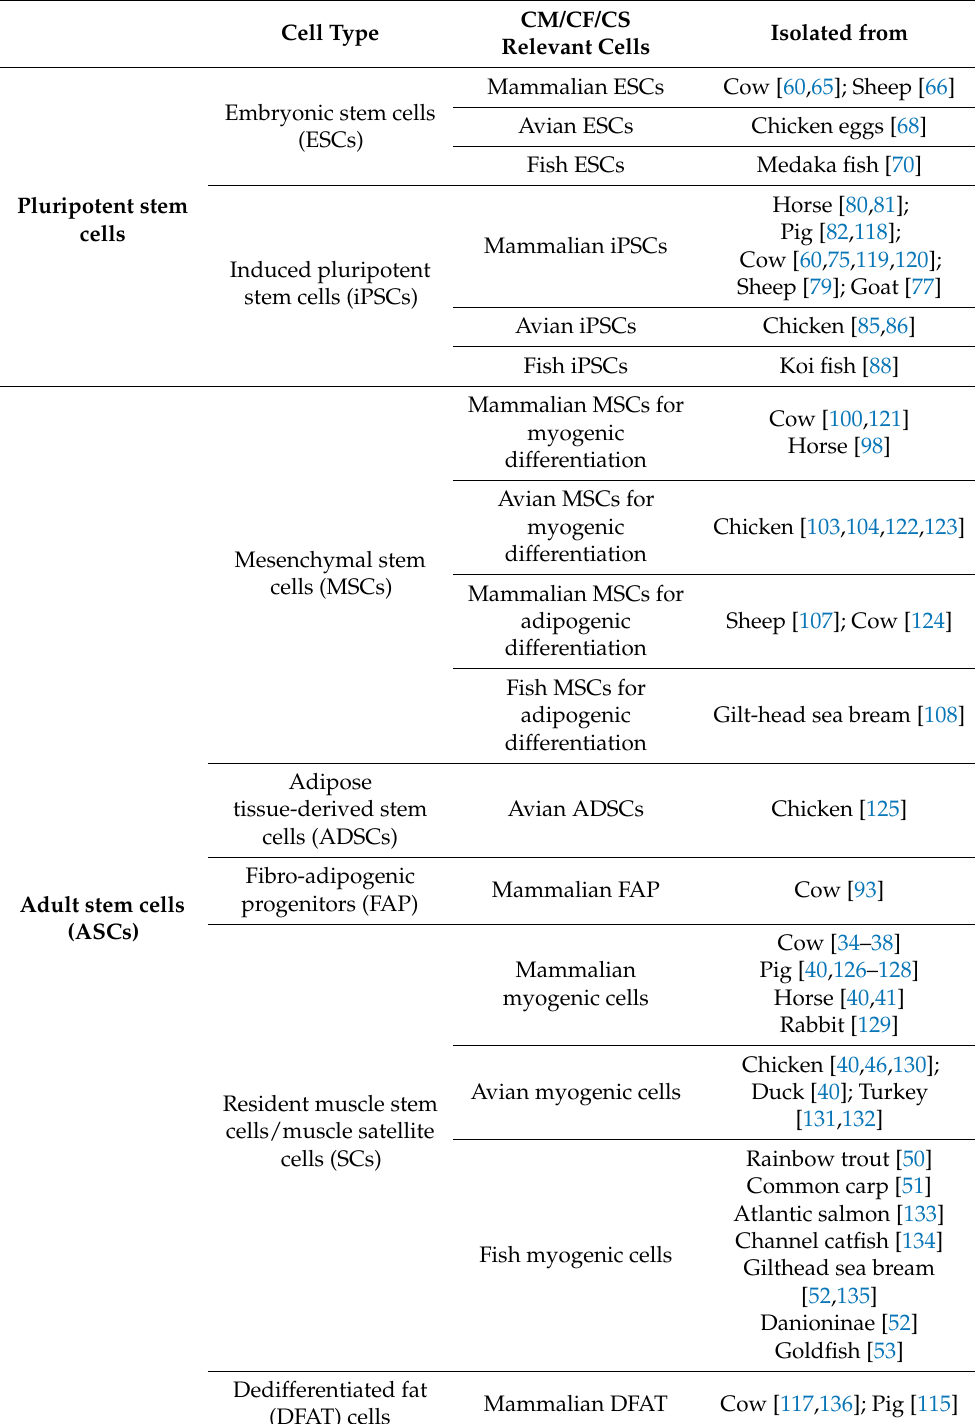
Table 1. List of cell types relevant for CM/CF/CS and animal species the cells are isolated